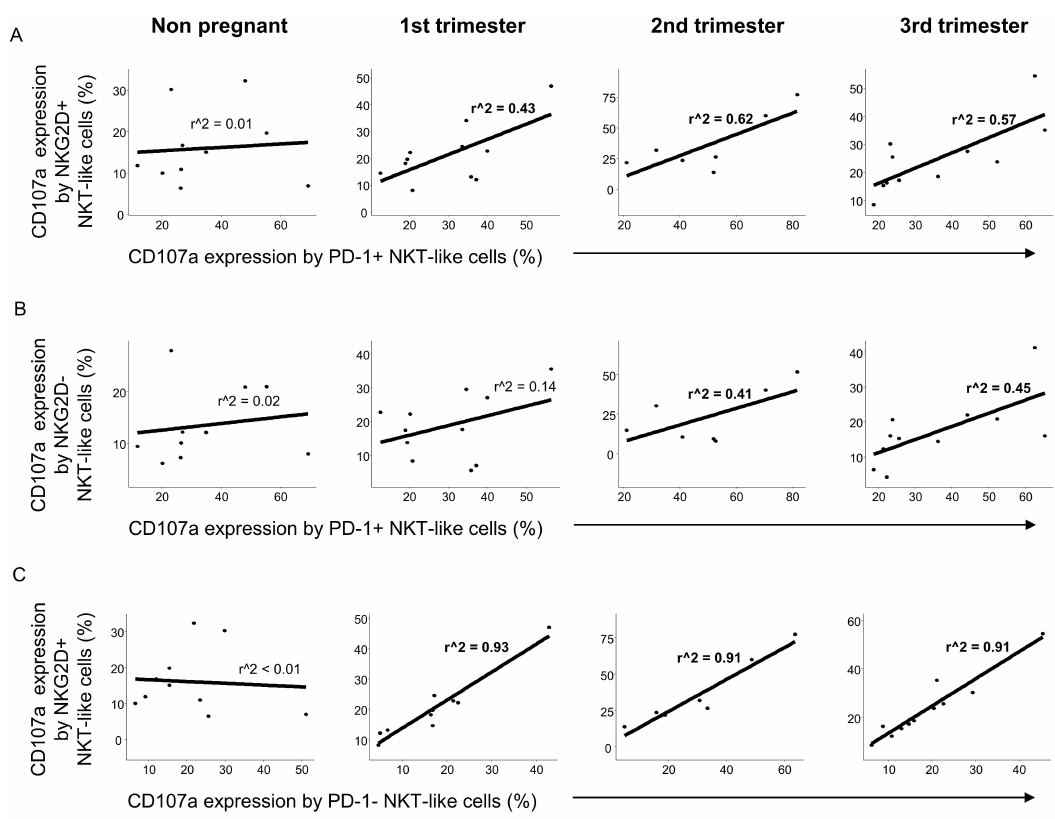
Figure 8. Regression analyses of the CD107a expression by PD-1 and NKG2D positive / negative subpopulations in NKT-like cells throughout pregnancy and in nonpregnant women. Linear regression analyses between the CD107a expression by the PD-1 +/ NKG2D + ( A ), PD-1 +/ NKG2D − ( B ) and PD-1 − / NKG2D + ( C ) subpopulations in NKT-like cells in women during healthy pregnancy and in nonpregnant women. p values and coe ffi cients of determination (R2) were calculated in